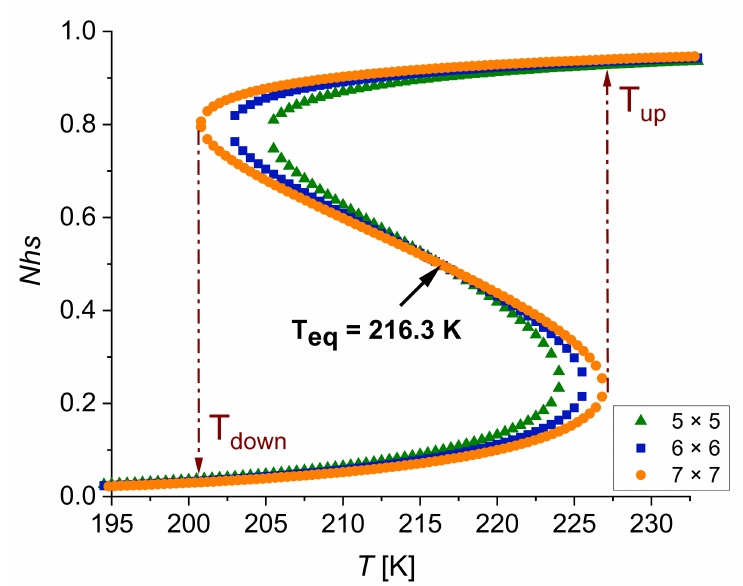
Figure 2. Thermal dependence of the HS fraction for square-shaped nanoparticles of different sizes: 5 × 5 (green up triangle), 6 × 6 (blue squares), 7 × 7 (orange circles). The computational parameters are: ∆ / k B = 1300 K, G / k B = 172 K, J bb / k B = 60 K, J ss / k B = 50 K, J bs / k B = 20 K, L / k B = 0 K and ln( g ) =